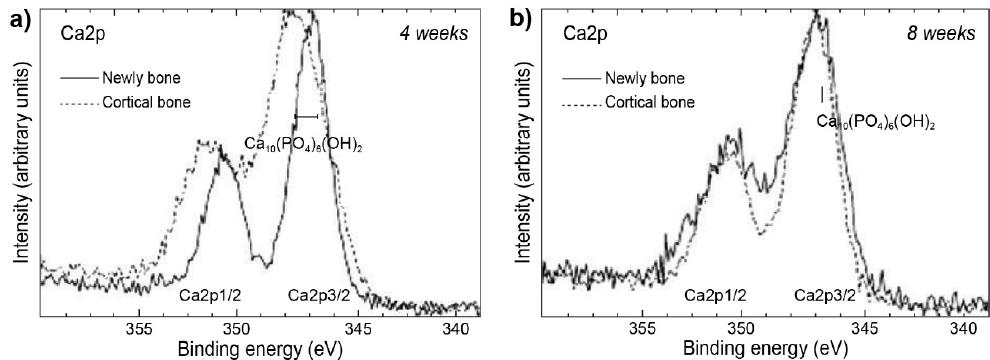
Figure 7. Narrow scan XPS spectra comparing newly formed and cortical bone after ( a ) four and ( b ) eight weeks. Figure adapted with permission from [52].